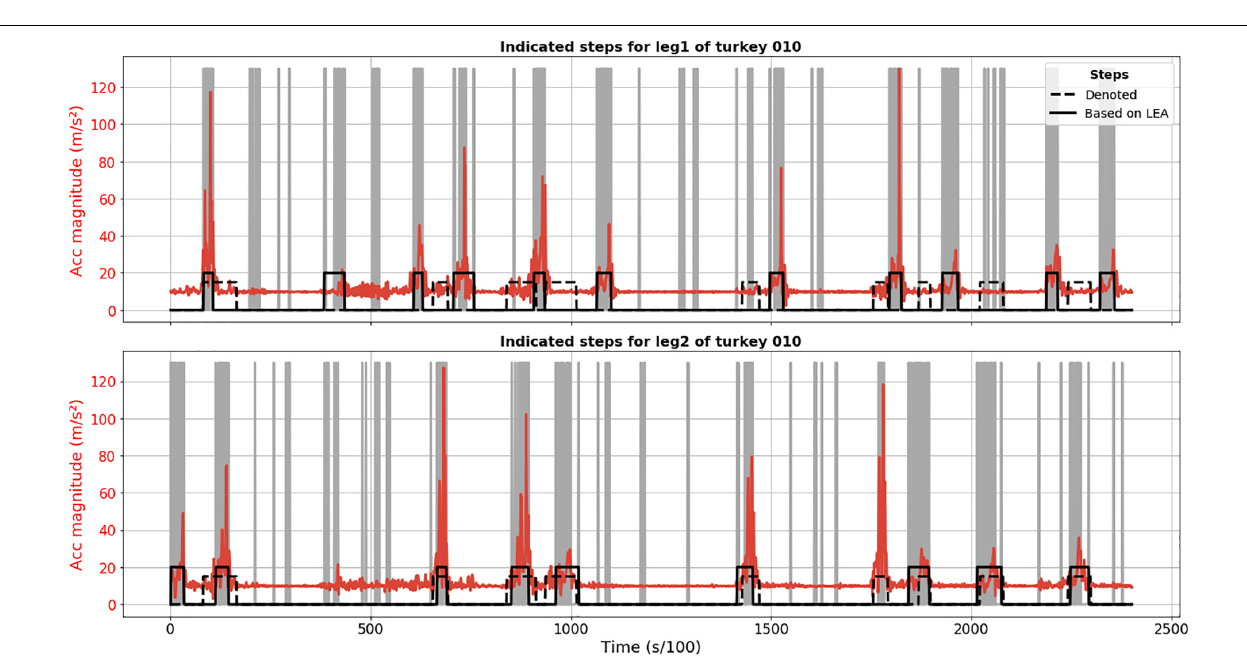
FIGURE 1 | Results of CPD step segmentation for turkey 010 (solid black line) for leg 1 (upper plot) and 2 (lower plot). Acceleration magnitude is plotted in red; dashed black line depicts manually labeled steps.